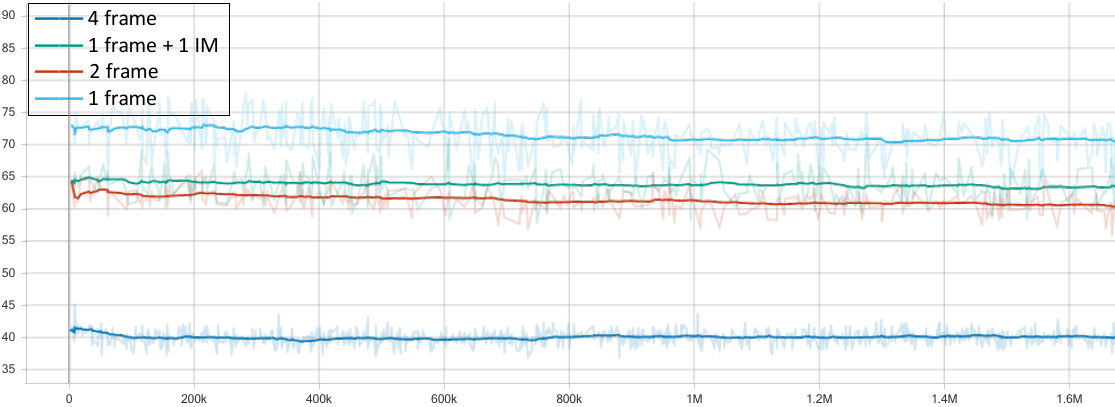
Figure 7. Training speed of four different image state spaces.